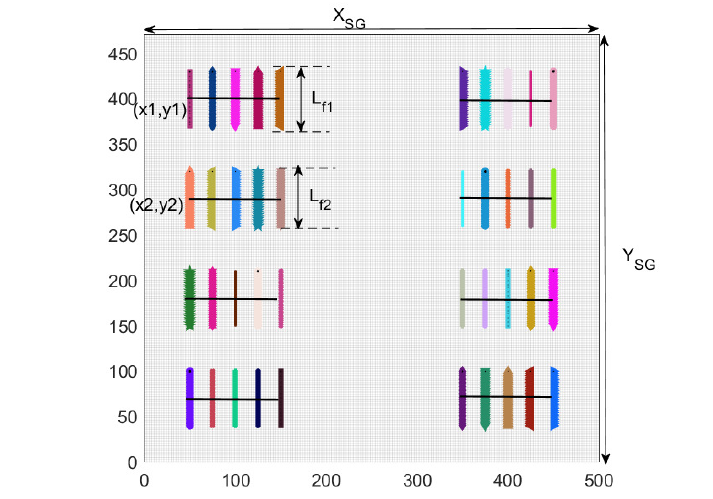
Figure 1. Illustration of multi-well placement in shale gas reservoir. The length and width of shale gas reservoir model are X SG and Y SG ,